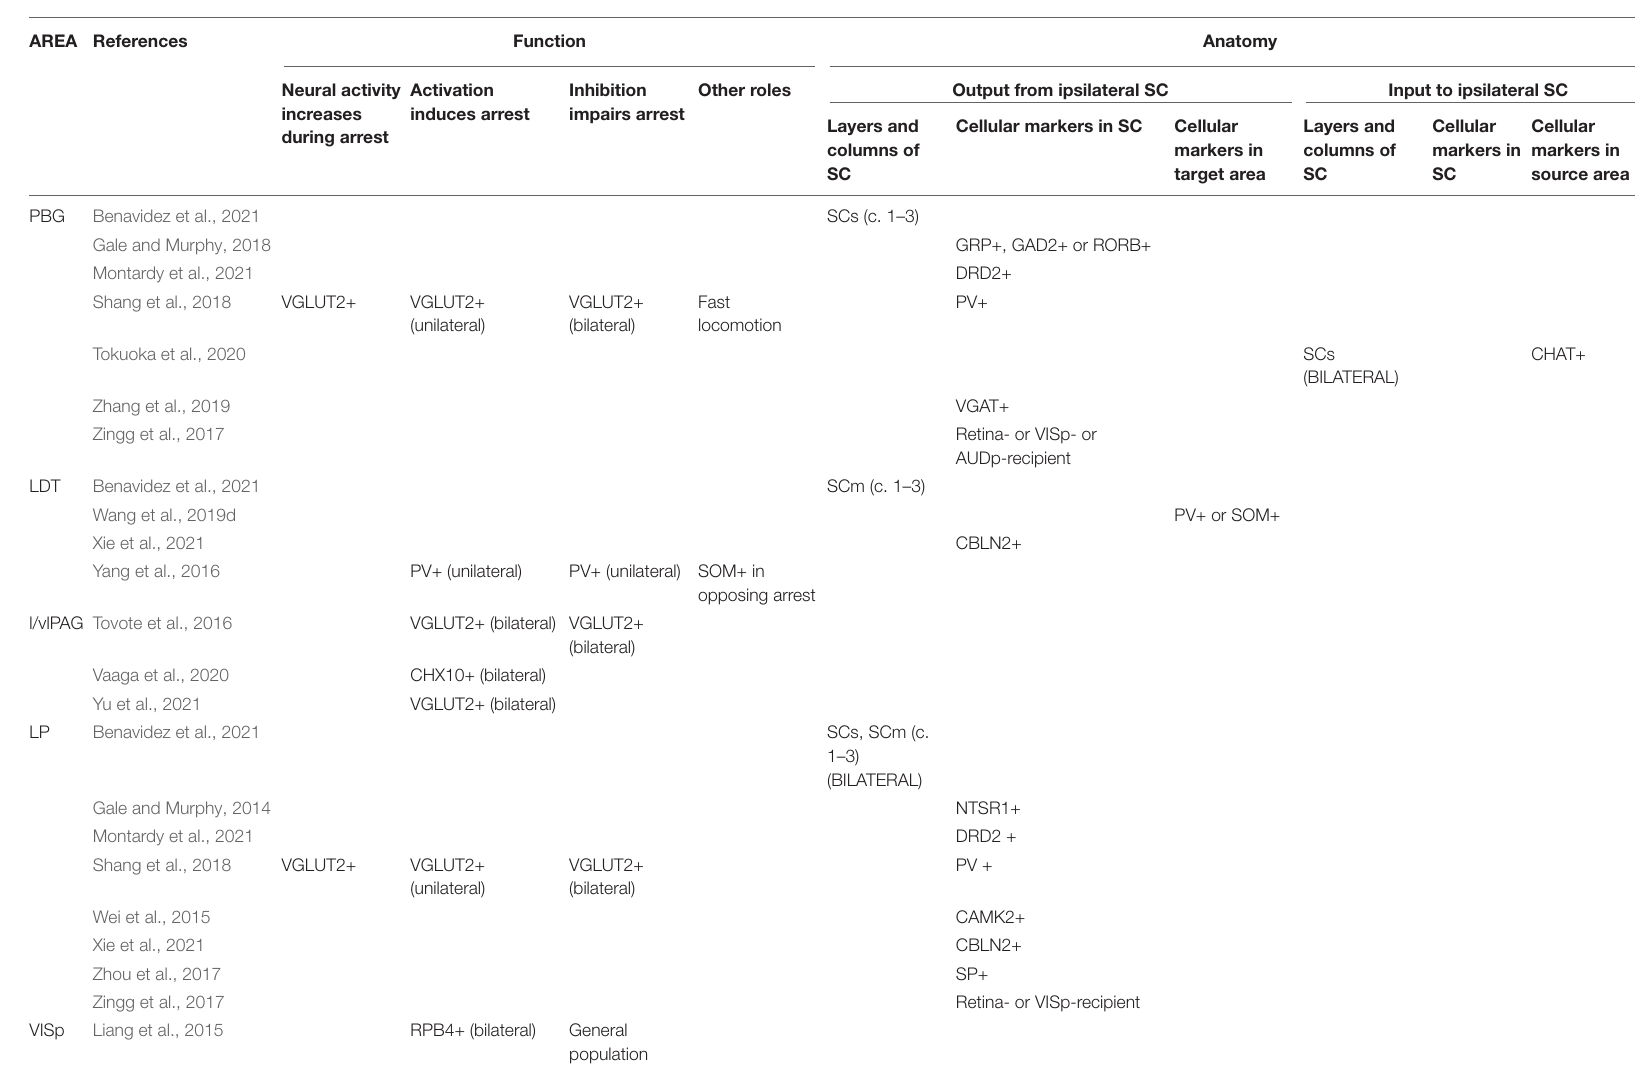
TABLE 1 | Areas reported to be involved in the production of arrest